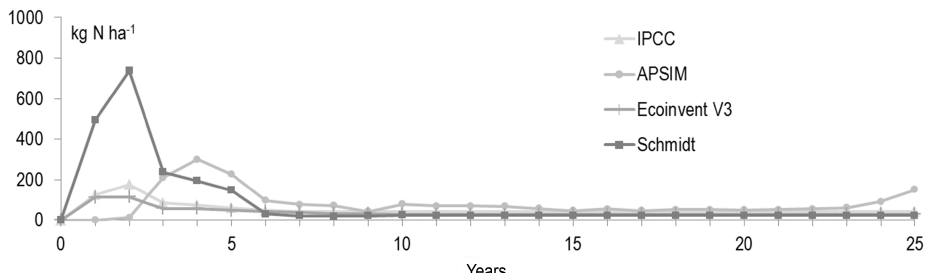
Figure 2. Temporal patterns of N losses along the growth cycle for four approaches selected to illustrate the variability of the results. Most of the models simulated maximum losses near the beginning of the cycle. The timing of the peak depended on the model, occurring between the first and the fourth year. The magnitude of the peak was very variable, up to 738kg Nha − 1 yr − 1 for